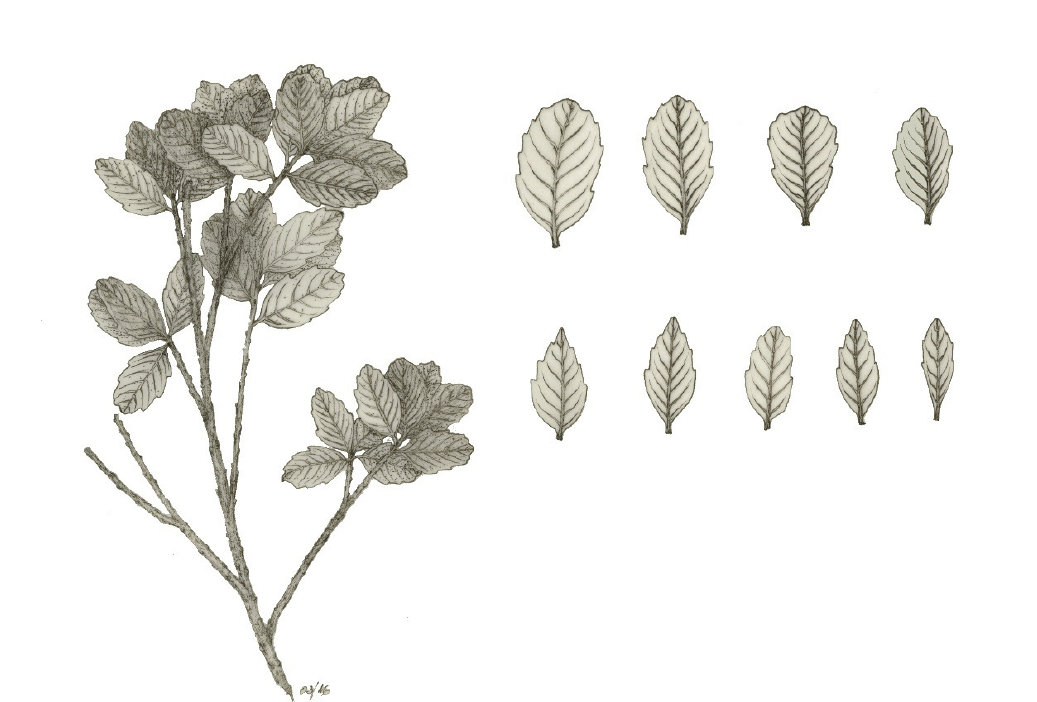
Figure 4. Illustration of Q. × alvesii Vila-Viçosa, Capelo, R. Almeida & F.M. Vázquez nothosp.nov. Branch and leaf type morphologies (F.M.